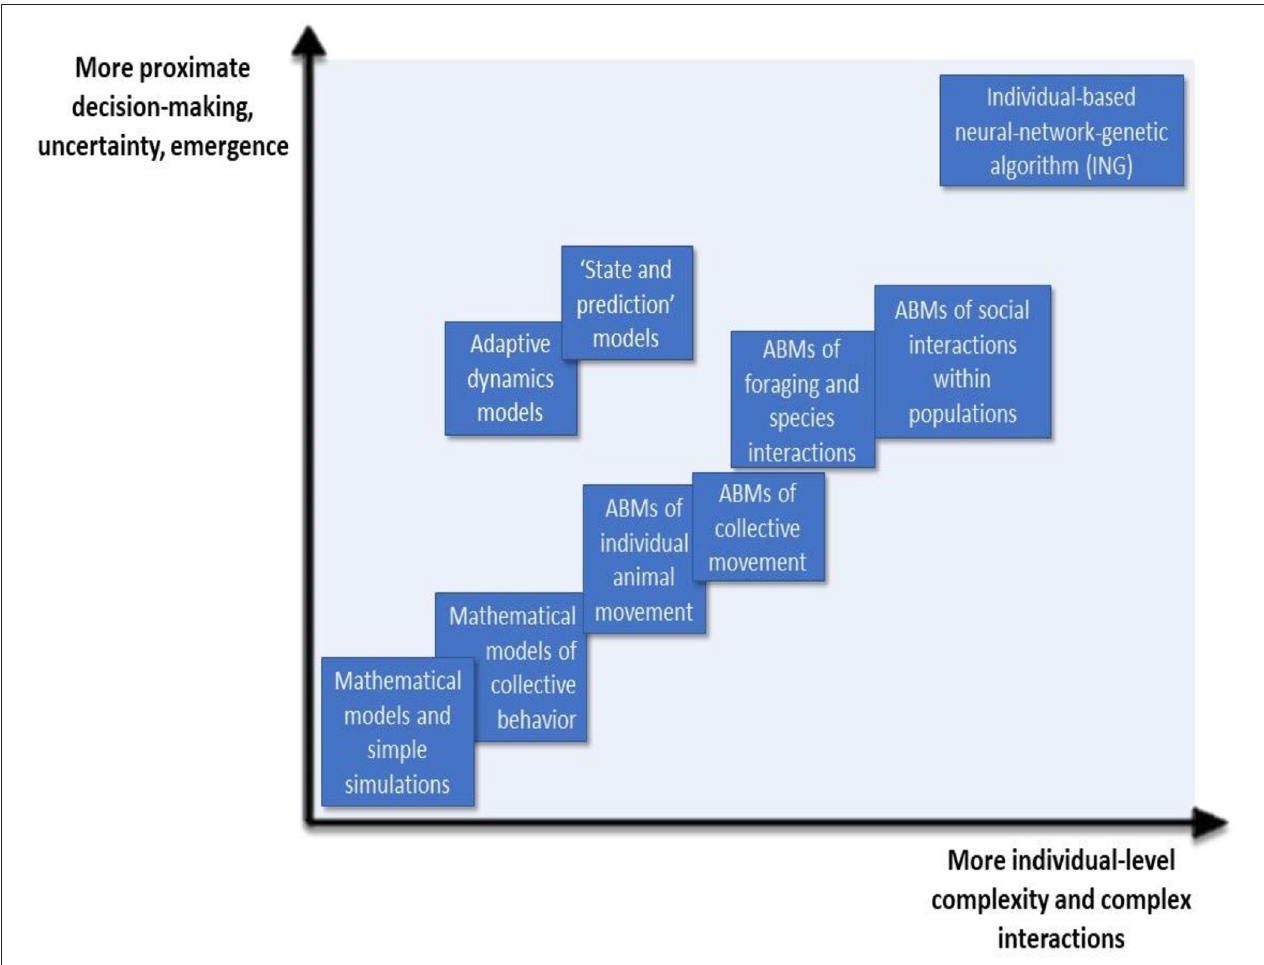
FIGURE 1 | Schematic representation of the models and methodologies utilized to model decision-making in ecology. Along the horizontal axis, these models and methodologies are able to introduce greater individual complexity and represent more complex interactions. Along the vertical axis, the models’ entities can be characterized by more proximate decision-making. There is more uncertainty introduced along this axis, but also a greater level of emergence, or higher-level behaviors resulting from lower-level